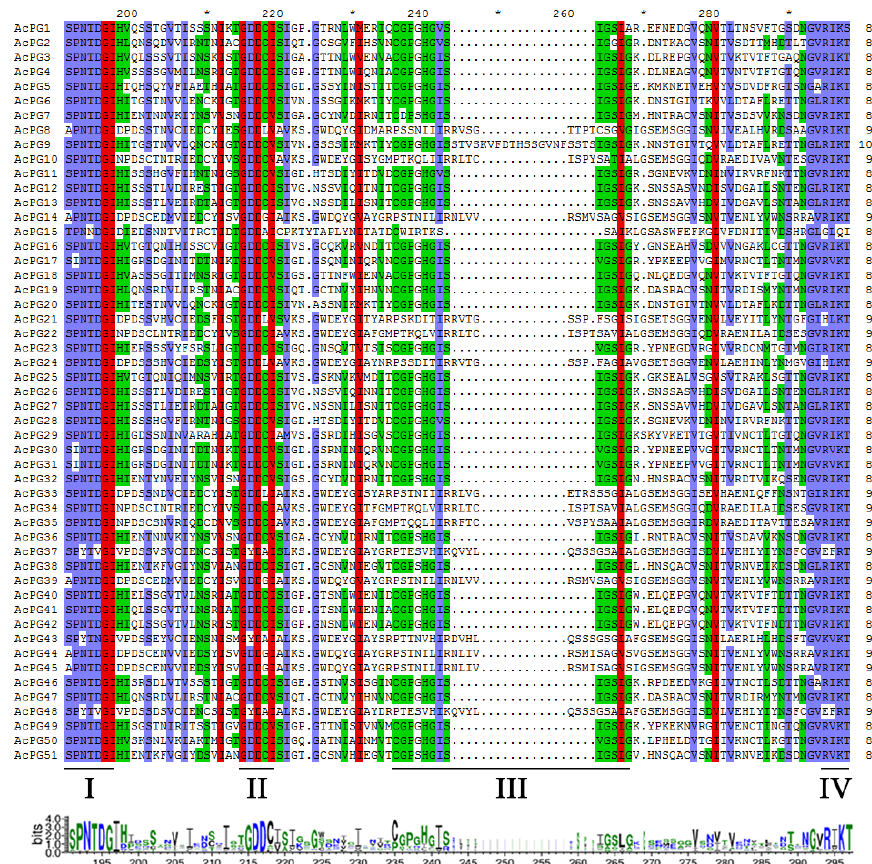
Figure 1. Multiple sequence alignment of peptides of kiwifruit PGs containing the four conserved domains. The underlines indicate the four typical conserved domains of PGs, referred to as domain I, II, III and IV as previously reported (Qian et al., 2016). Different shading colors illustrate different similarities (red: 100%, blue: ≥ 80%, green: ≥ 60%). The consensus sequence is shown at the bottom by letter logos. The bit score indicates the relative frequency of each amino acid at that position.